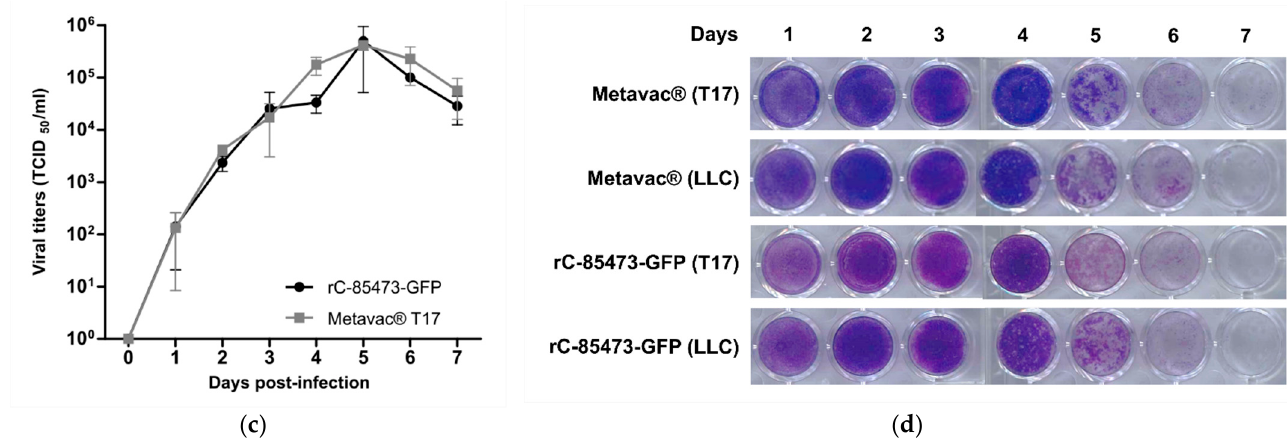
Figure 4. Visualization of T17-produced rC-85473-GFP and Metavac ® virus particles, and evaluation of in vitro replicative capacity. ( a ) Representative negative stain electron microscopy images of rC-85473-GFP and Metavac ® virions, obtained from DuckCelt ® -T17 culture. Bar represents 100 nm. Enlargements of viral membrane shown as inset, and glycoproteins indicated by white arrowheads; ( b , d ) LLC-MK2 monolayers in 24-well plates infected with each of the recombinant HMPVs at an MOI of 0.01. ( b ) Images of representative cytopathic effects of each virus captured after 4 dpi by fluorescent microscopy (10× magnification, scale bars represent 250µm). ( c ) Supernatants harvested every 24 h for 7 days, frozen, and subsequently thawed and titrated as TCID 50 /mL onto LLC-MK2 cells. Growth curves represent mean titers ± SD of 3 biological replicates, titrated at each time point. ( d ) Infected LLC-MK2 monolayers fixed in formaldehyde after harvest, and images captured after crystal violet coloration.